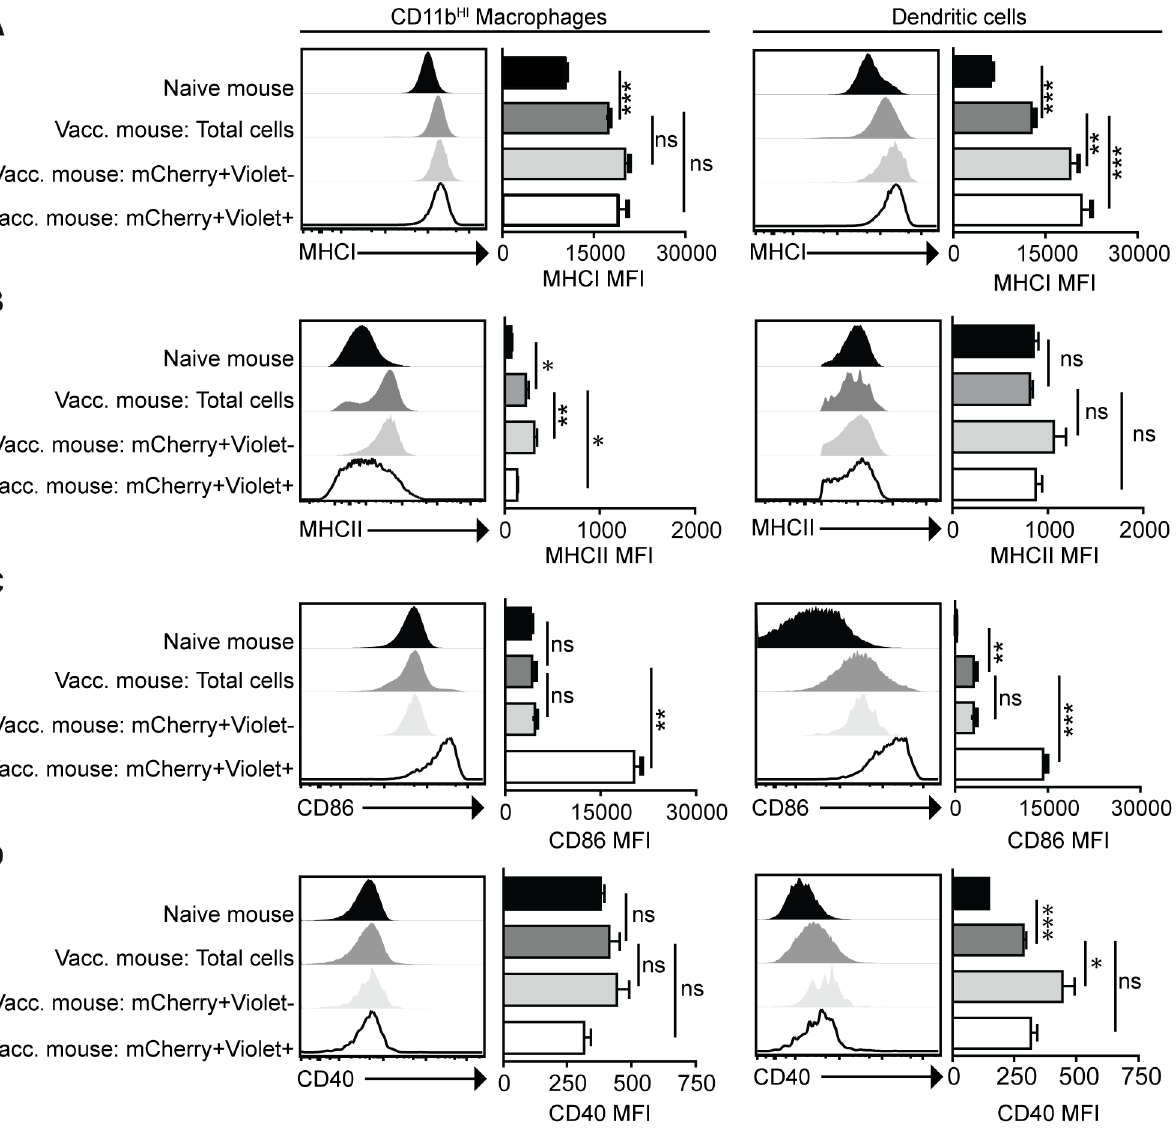
Figure 4. Activation status of mCherry + ve Violet 2 ve and mCherry + ve Violet + ve macrophages and dendritic cells. Mice were administered parasites as described in Figure 3. At 18 hours post-vaccination, expression of the antigen presentation molecules MHCI (a) and MHCII (b) and expression of the costimulatory molecules CD86 (c) and CD40 (d) on CD11b HI macrophages and dendritic cells was determined by flow cytometry. Macrophages are identified as CD3 2 ve ,CD19 2 ve ,NK1.1 2 ve ,CD11c 2 ve ,Gr-1 2 ve ,CD11b HI cells. Dendritic cells are identified as CD3 2 ve ,CD19 2 ve ,NK1.1 2 ve , CD11c HI ,MCHII HI . Confidence intervals were determined using the Bonferroni correction method. *p , 0.017; **p , 0.0017; ***p , 0.00017. AVG 6 SE. Paired, two-tailed student’s t tests were used to compare expression levels of molecules on populations within cpsII -vaccinated mice.